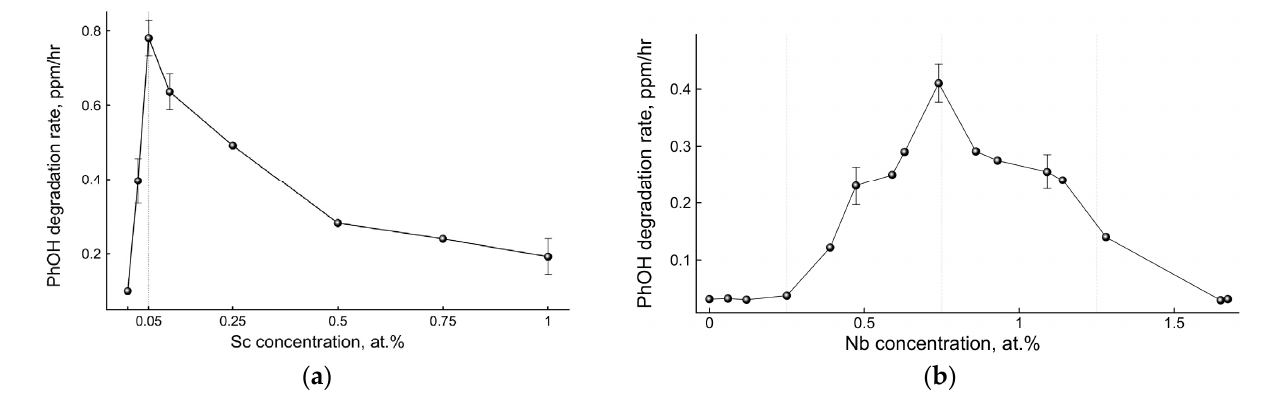
Figure 2. Experimental dependences of the initial rates of phenol photocatalytic degradation on dopant concentrations in TiO 2 : ( a ) Sc 3+ and ( b ) Nb 5+ .